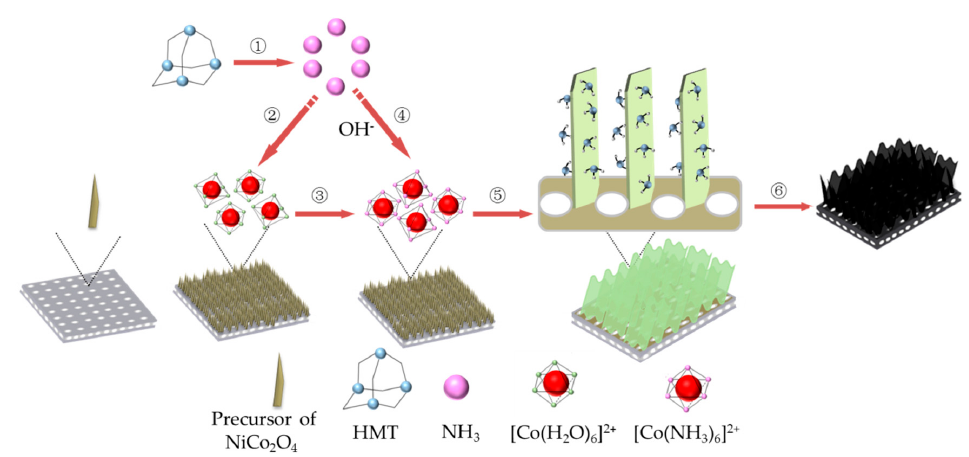
Figure 3. Schematic illustration of the synthesis process for Co 3 O 4 nanosheets.